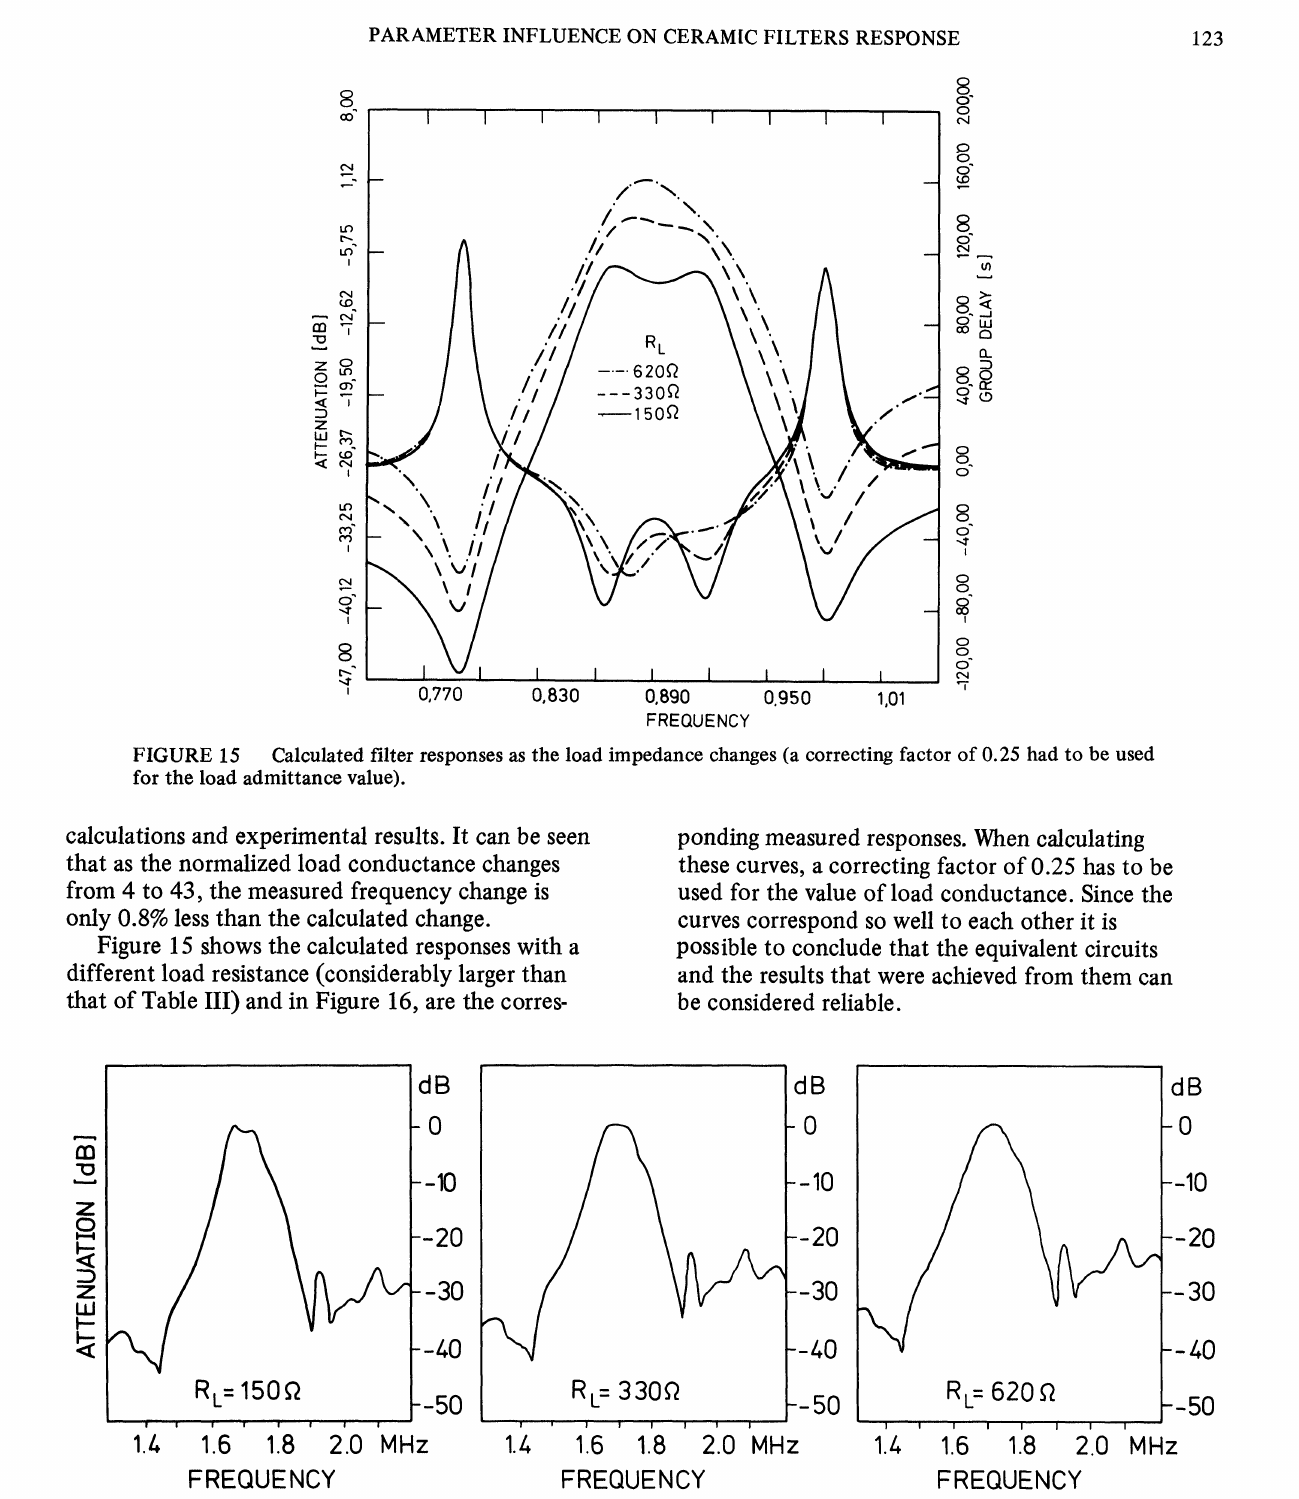
The measured filter responses of the filter whose calculated responses are shown in Figure